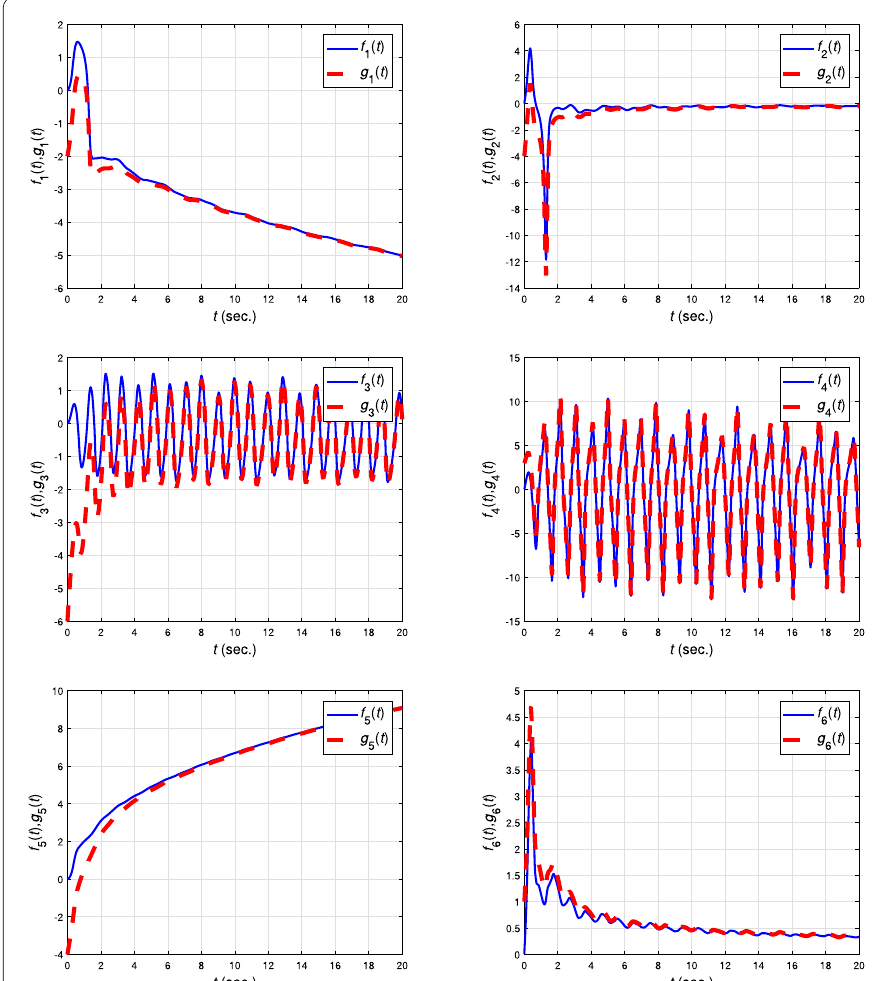
Figure 9 The synchronized state variables of the fractional-order cardiac conduction systems (10) and (35) with q =